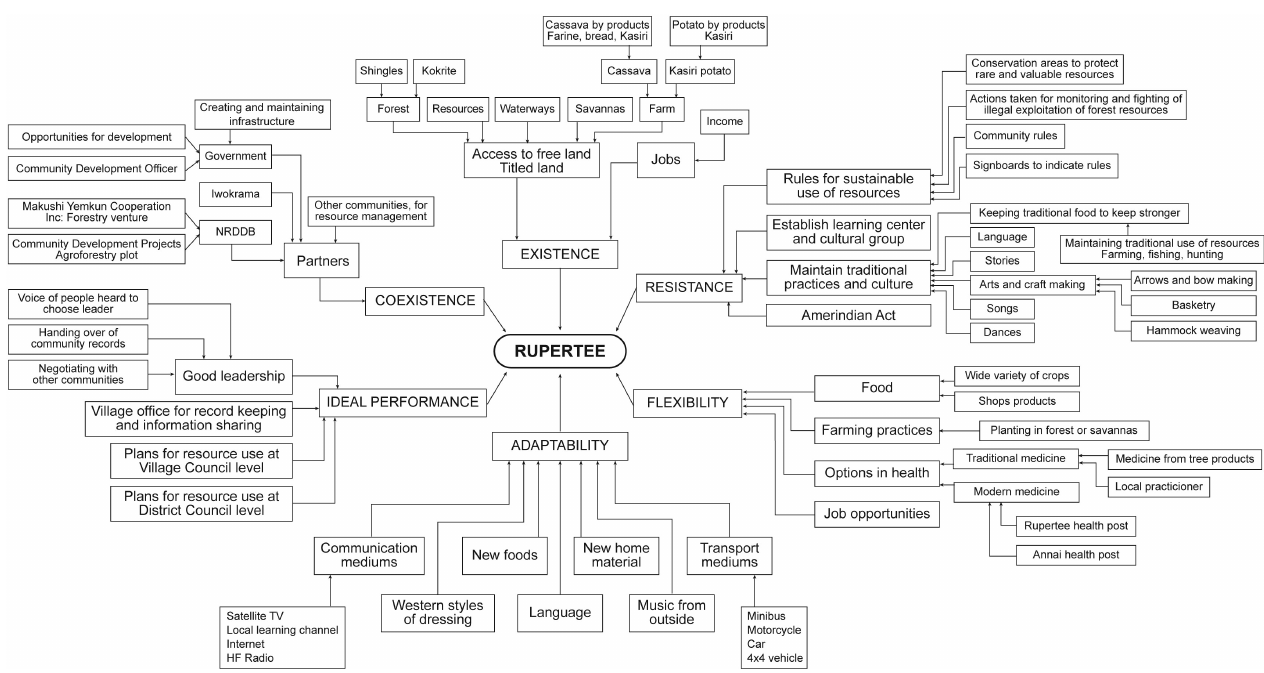
Fig. 3 . Example of an indicator spray